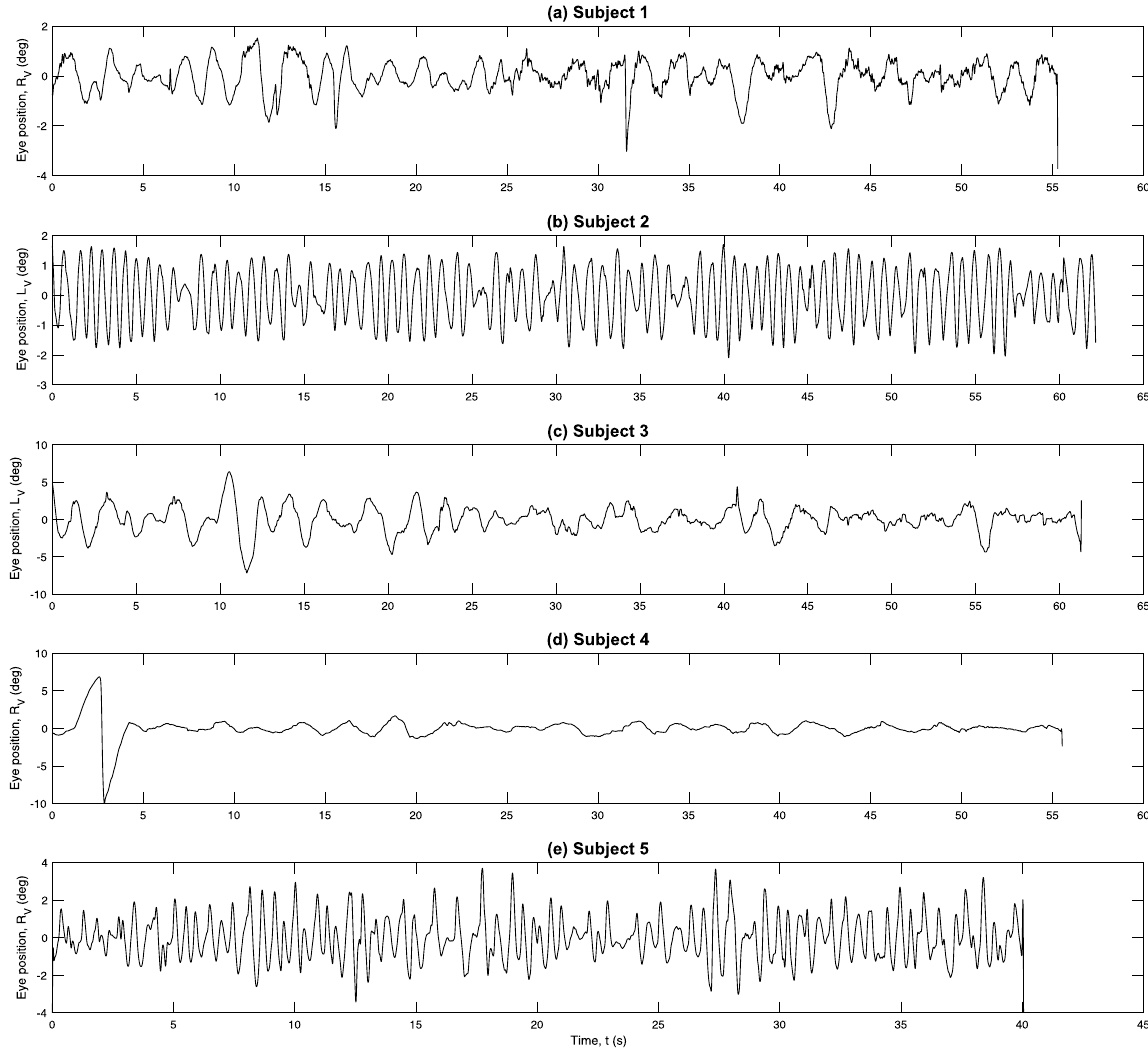
Figure 3. Time series used for the permutation entropy calculations (see text for further details).